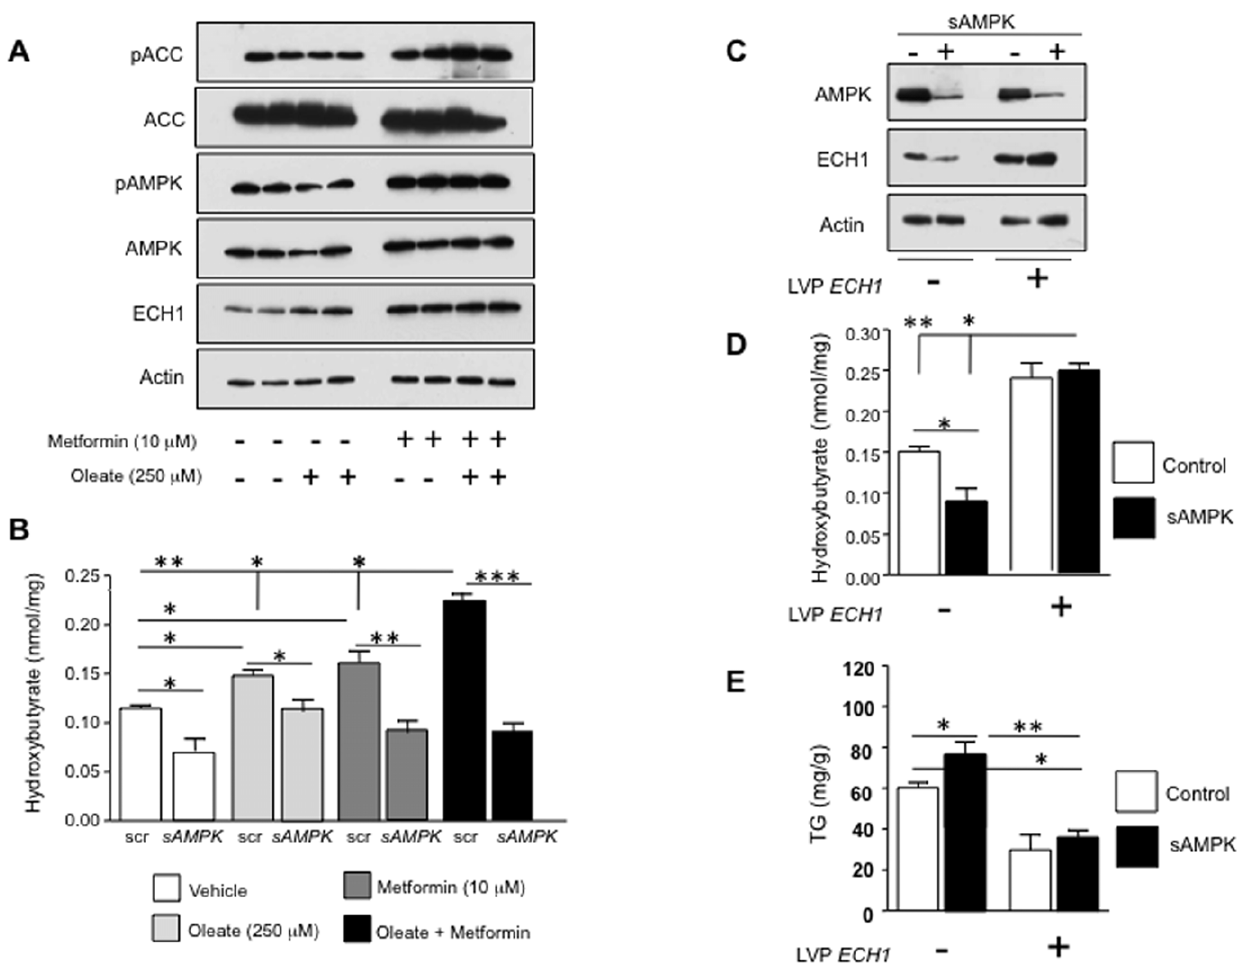
Figure 1. Activation of AMPK stimulates fat oxidation in HepG2 cells. A) Stimulation of AMPK activity by metformin (10 m M) significantly increases the phosphorylation of AMPK at Thr172, the phosphorylation of ACC at ser79 as well as the expression of the fat oxidation-related protein ECH1 (Enoyl CoA-hydratase) B) Metformin up-regulates the accumulation of b -hydroxybutyrate -a marker of fat oxidation activity- in cells exposed to oleic acid (250 m M, 72 hour). Hydroxybutyrate accumulation, ACC phosphorylation and ECH1 up-regulation by metformin does not occur in AMPK- deficient cells. *p , 0.05, **p , 0.01, ***p , 0.001 C) Representative western blot showing over-expression of ECH1 in HepG2 cells (lanes 3 and 4) in control cells (lanes 1 and 3) and AMPK deficient cells (lanes 2 and 4). ECH1 overexpression restores the loss of fat oxidation observed in AMPK deficient cells and reduces fat accumulation as determined by a significant up-regulation of b -hydroxybuyrate levels (D) with paralleled decrease in intracellular triglyceride levels (E) *p , 0.05, **p ,